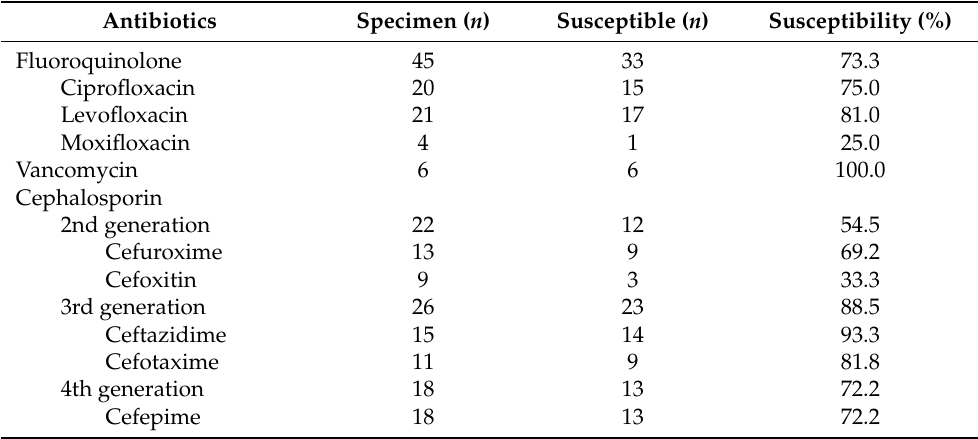
Table 5. Antibiotics susceptibility of cultured